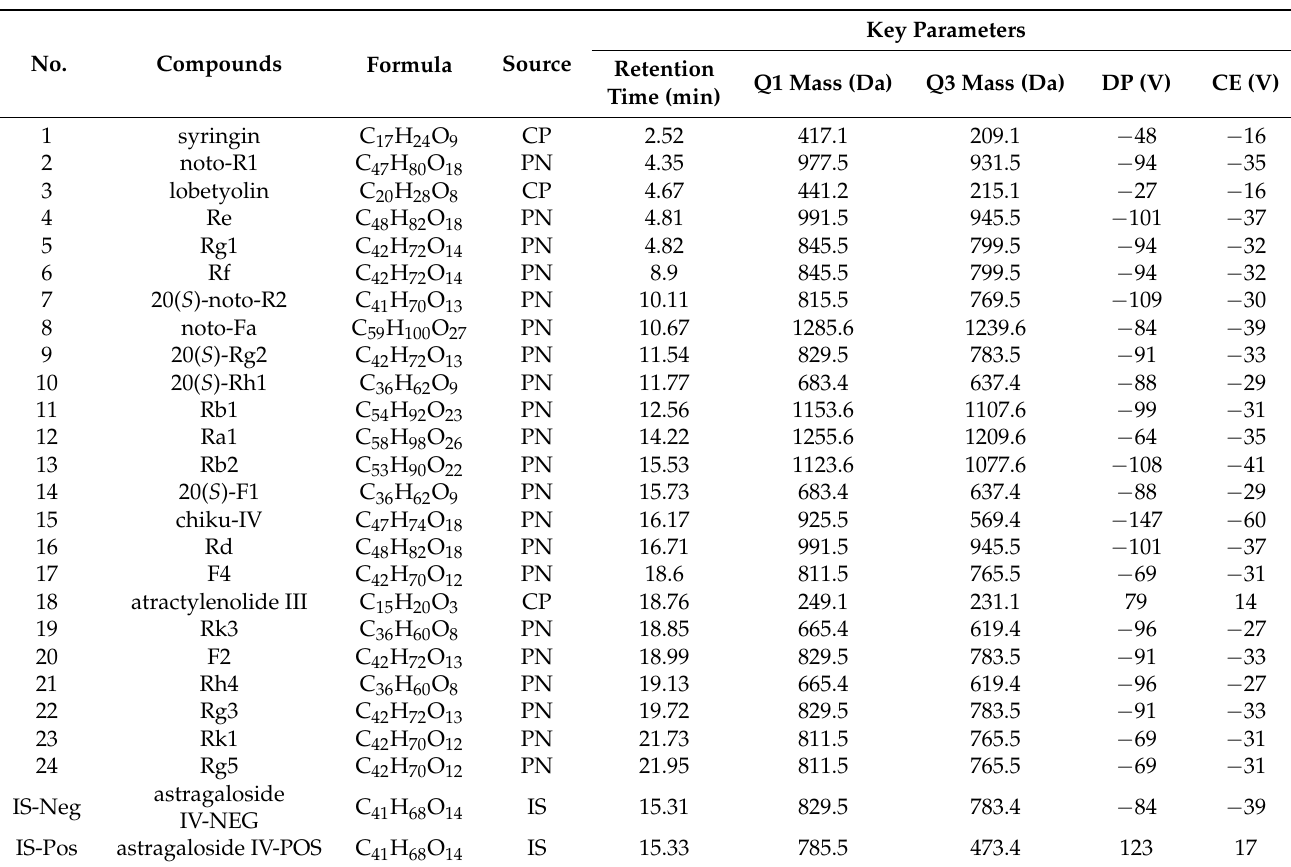
Table 1. The sMRM parameters for the quantitative assay of 24 compounds from WXG.